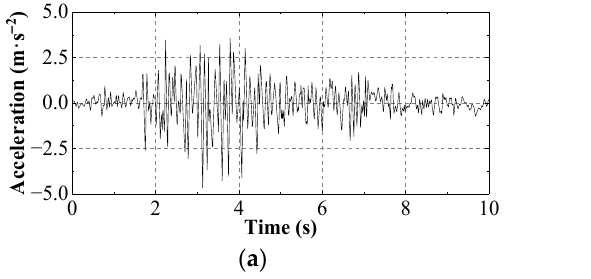
Figure 6. Koyna earthquake accelerations. ( a ) Horizontal component; ( b ) vertical component.